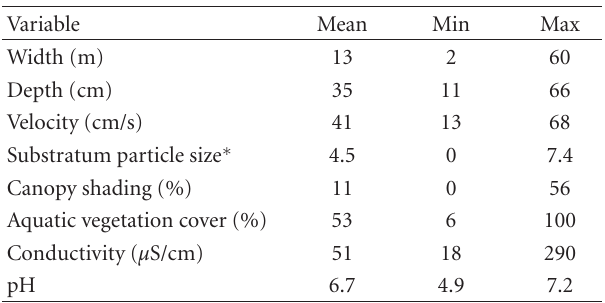
Table 1: Habitat characteristics of the sampling sites ( n =